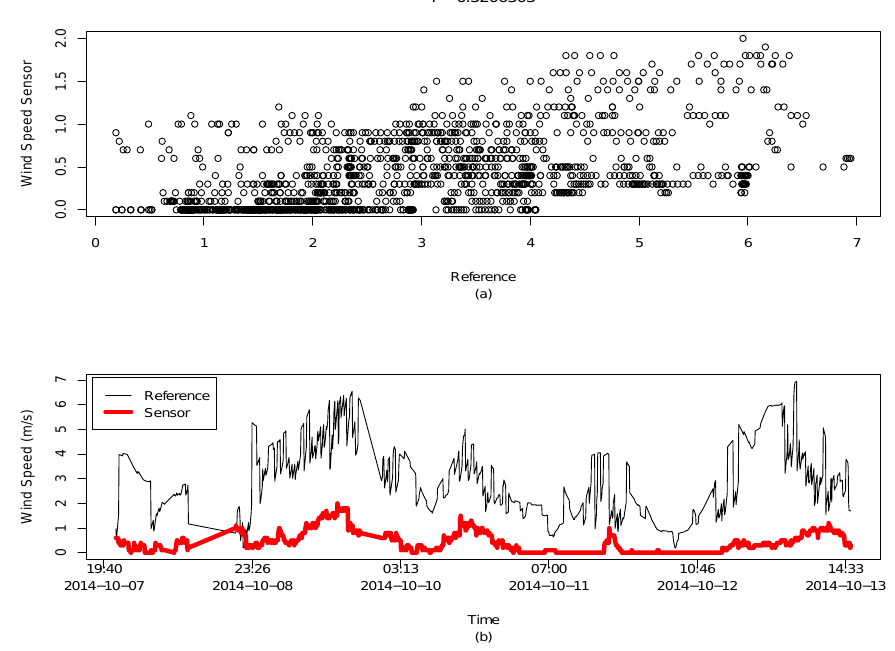
Figure 15. Analysis of the single wind speed sensor, with r = 0 . 5206303 , in a range of 100 km from the coordinates of London, UK, in Dataset 2: ( a ) scatter plot between the reference and this sensor; and ( b ) the time series analysis of its